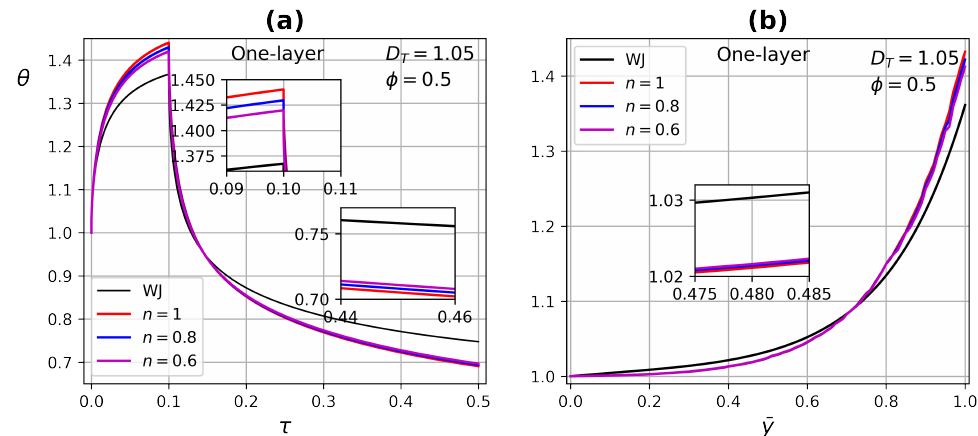
Figure 14. Temperature profiles as a function of ( a ) time and ( b ) tissue layer depth, for different power-law index n at τ = 0.09 and porosity φ =